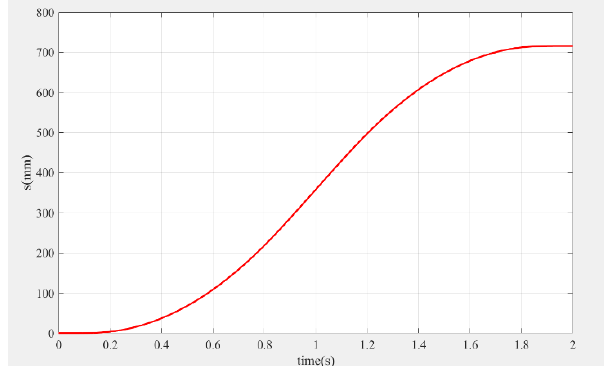
Figure 9. The distance curve of the execution end.